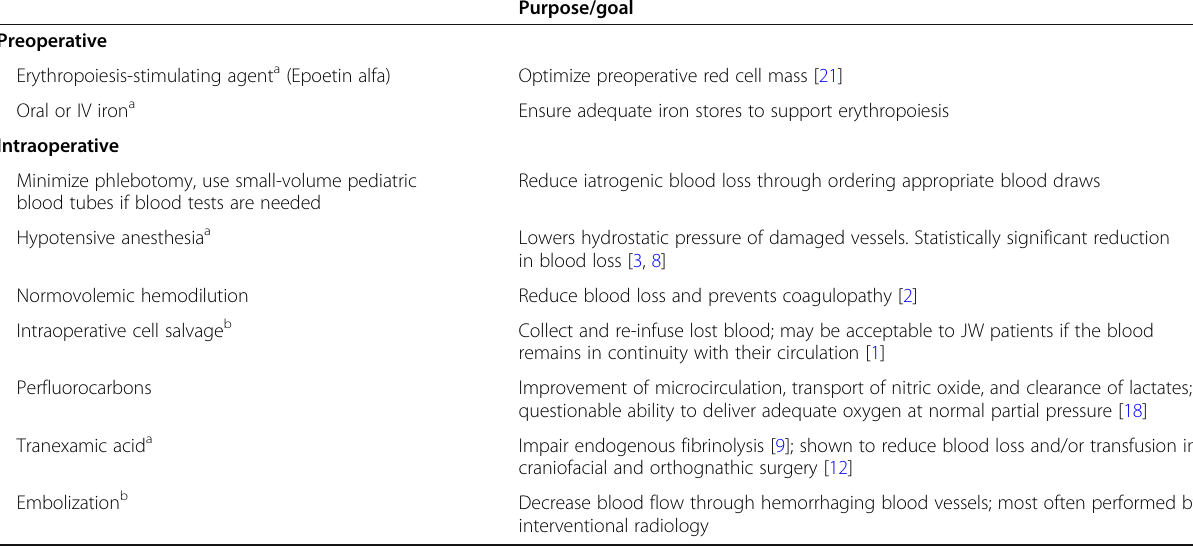
Table 1 Strategies for minimizing blood loss